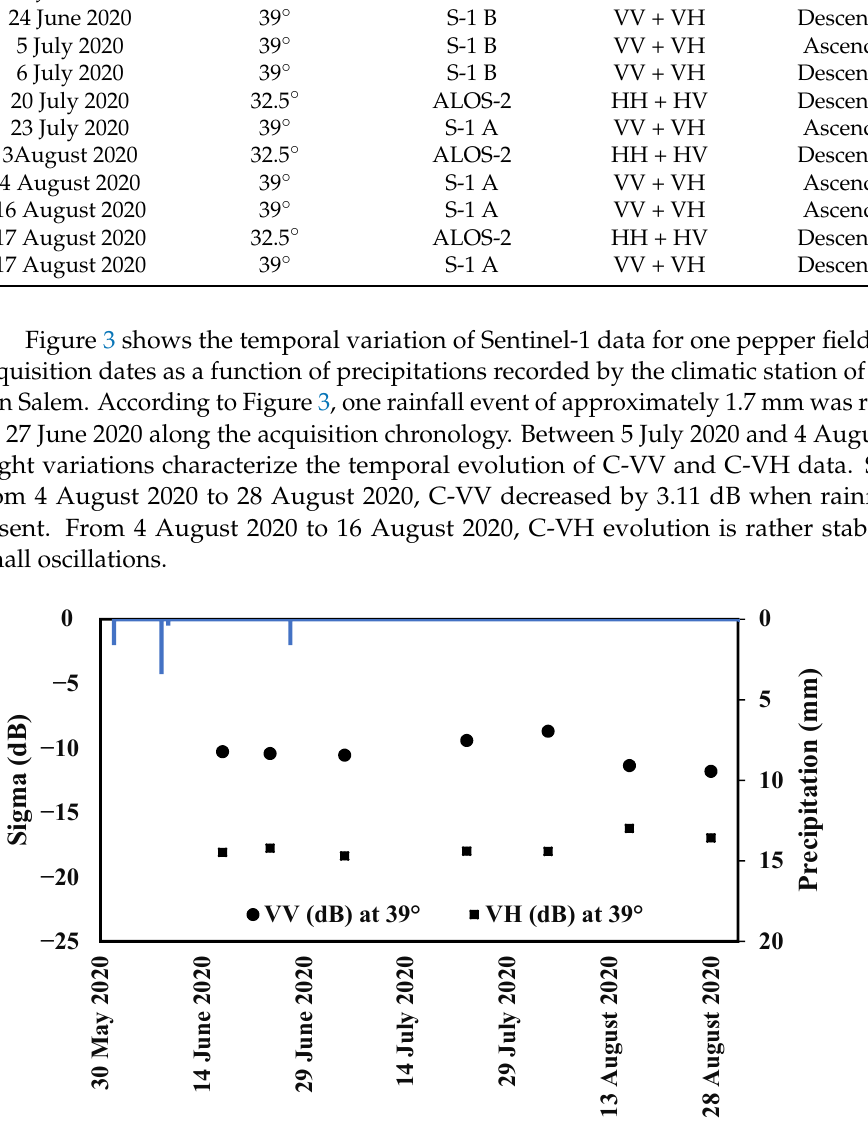
Figure 3. C ‐ band Sentinel ‐ 1 backscattering coefficients (sigma) in dual ‐ polarization VV and VH at Figure 3. C-band Sentinel-1 backscattering coefficients (sigma) in dual-polarization VV and VH at an incidence angle of 39 ◦ and the precipitation quantity temporal evolutions during June, July,